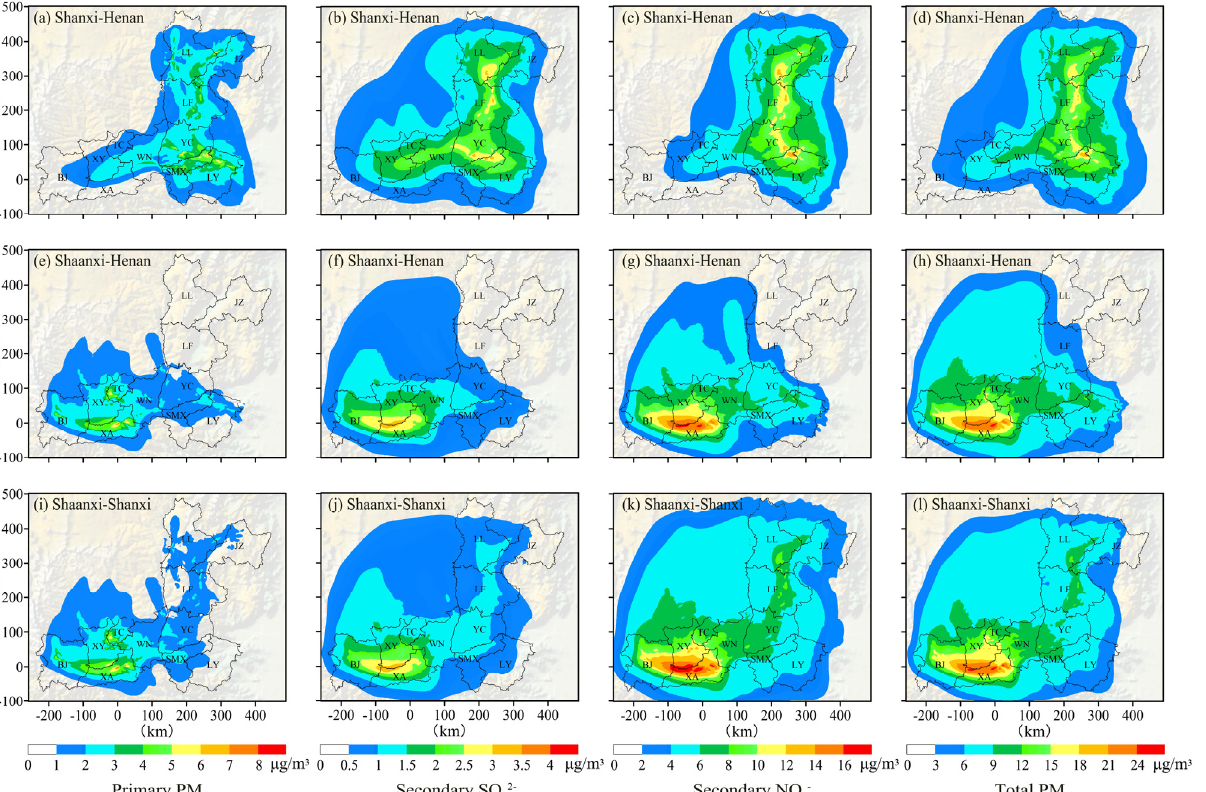
Figure 5. The spatial distributions of the maximum hourly concentrations of primary PM 2.5 , second- ary SO 42 − , secondary NO 3 − , and total PM 2.5 from the Shanxi–Henan group ( a – d ), the Shaanxi–Henan group ( e – h ), and the Shaanxi–Shanxi group ( i – l ) in January